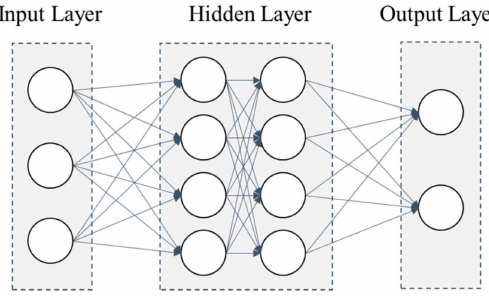
Figure 2. Multilayer perceptron (MLP) process.